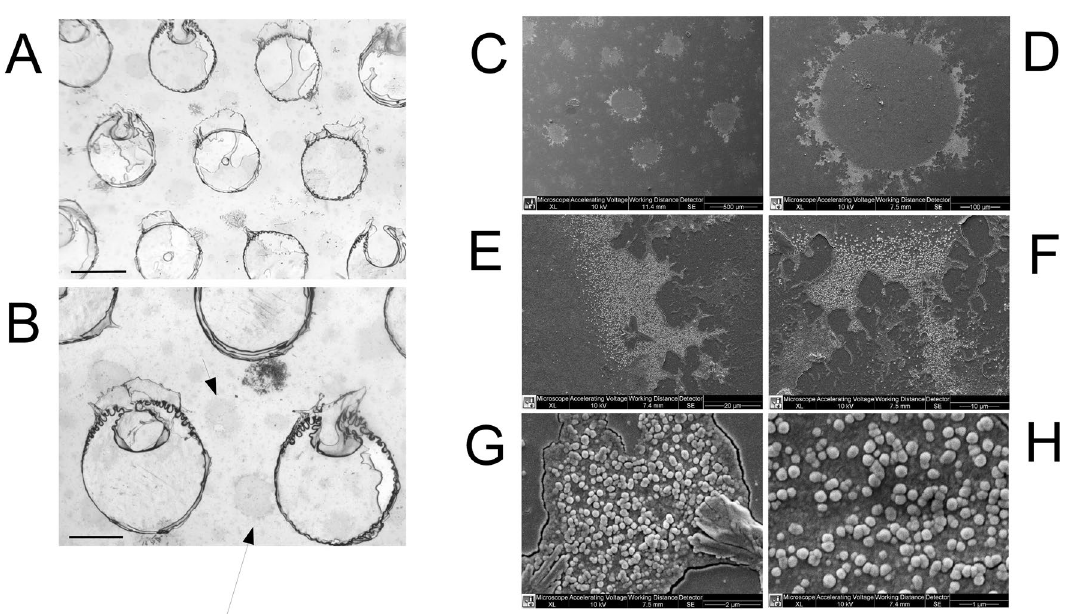
Figure 9. Optical ( A , B ) and Scanning Electronic Microscopy (SEM) ( C – H ) imaging of the WIWELL TiO 2 –Ag–NP photocatalytic surface. ( A ) Porose structure of the film (width bar = 1 mm); ( B ) Structure of the photocatalytic film with photocatalytic macro-spots (arrows) (width bar = 0.5 mm); ( C ) SEM of the photocatalytic macro-spots (500 μm), with an exemplificative imaging sample ( D ) showing the fractal-like dispersion area at the boundary (100 μm). ( E ) Focus at the boundary at 20 μm and ( F ) 10 μm, showing the photocatalytic complex; ( G ) Nano-imaging of the TiO 2 –Ag–NP complex at 2 μm and ( H ) 1